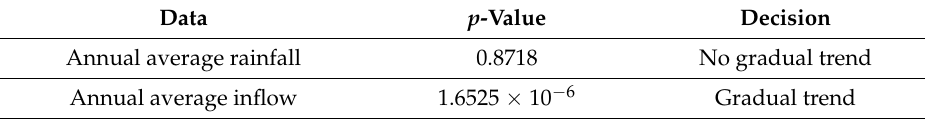
Table 3. Results of Mann–Kendall non-parametric trend test (significance level: 5%).